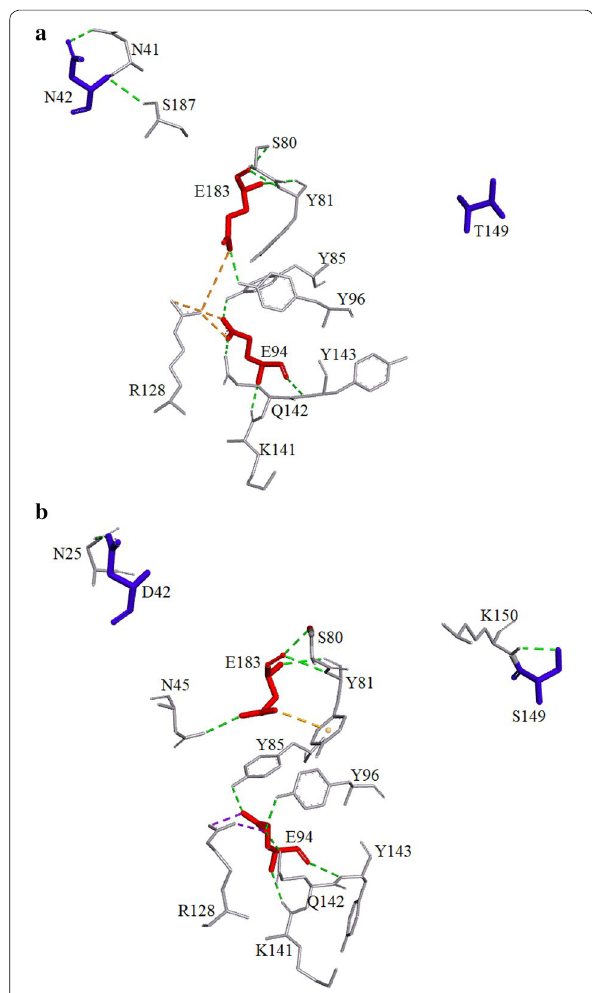
Fig. 4 Interactions of the catalytic residues (E94 and E183, marked in red) and the mutated amino acids (marked in blue) with their surroundings (marked in gray) of XynHBN188A ( a ) and XynHBN188A217 ( b ). The green dashed lines indicate hydrogen bonds, the yellow dashed lines indicate electrostatic interactions, and the purple dashed lines indicate salt